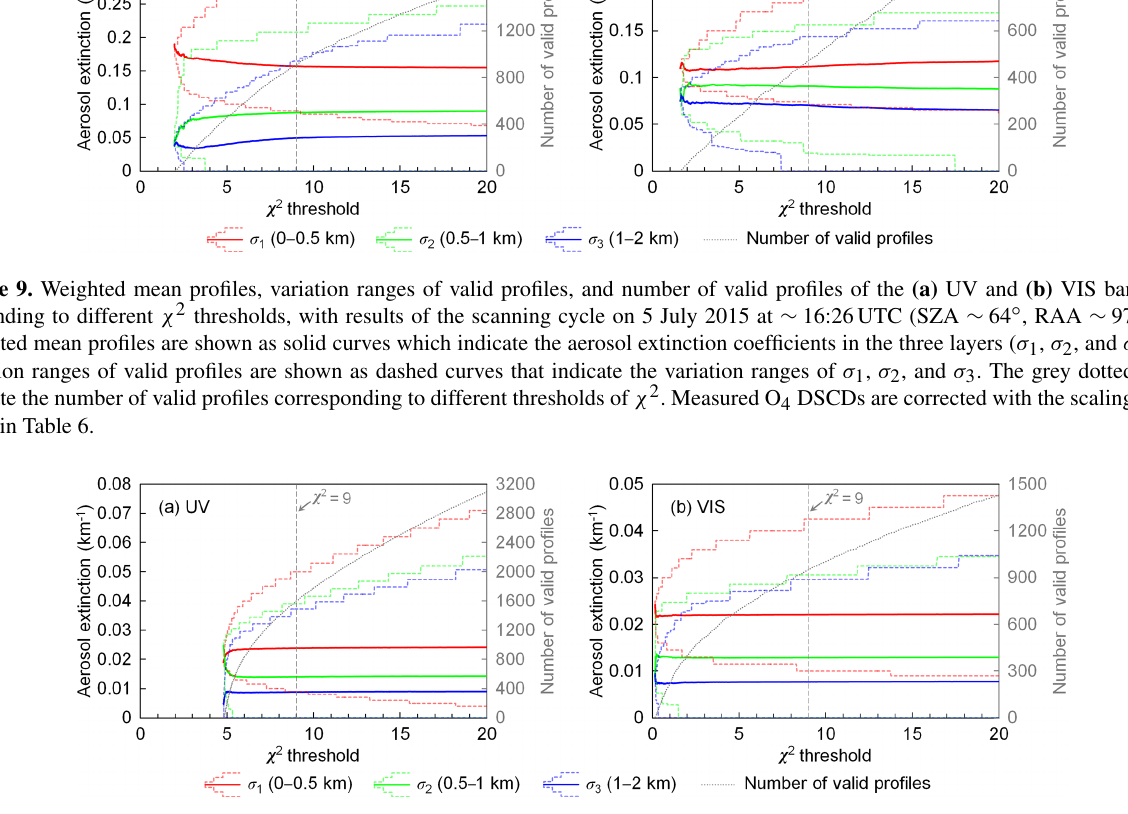
Figure 10. Same as Fig. 9, but for the scanning cycle on 7 December 2015 at ∼ 13:55UTC (SZA ∼ 79 ◦ , RAA ∼ 39 ◦